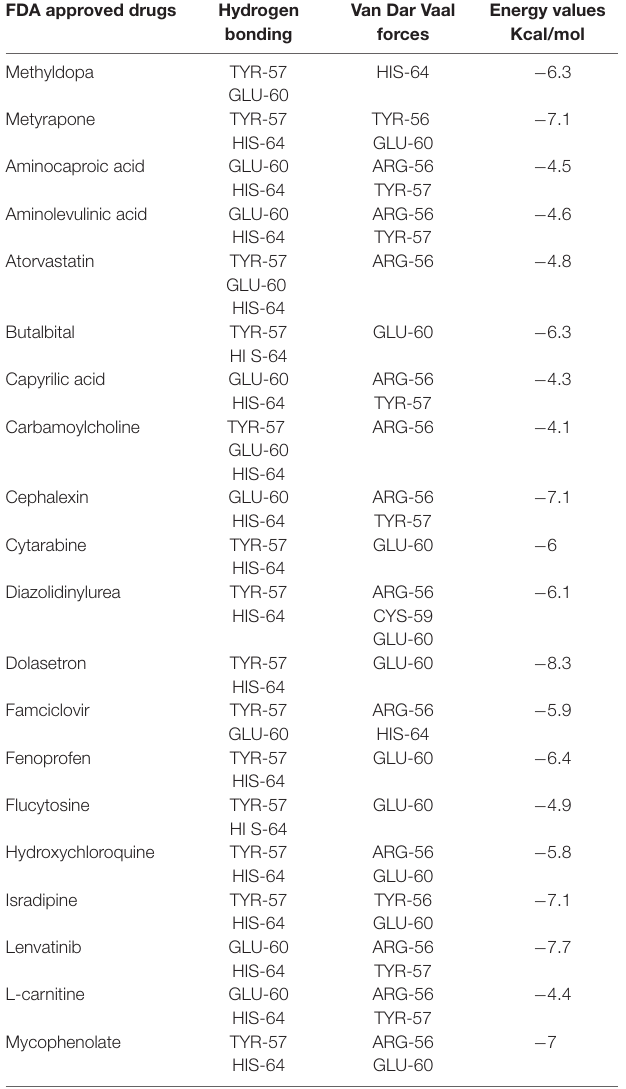
TABLE 1 | E-value (Kcal/mol) and post-docking analysis (interactions) of methyldopa, metyrapone, aminocaproic acid, aminolevulinic acid, atorvastatin, butalbital, caprylic acid, carbamoylcholine, cephalexin, cytarabine, diazolidinyl urea, dolasetron, famciclovir, fenoprofen, flucytosine, hydroxychloroquine, isradipine, lenvatinib, L-carnitine, and mycophenolate with nuclear factor kappa beta (NF- κ